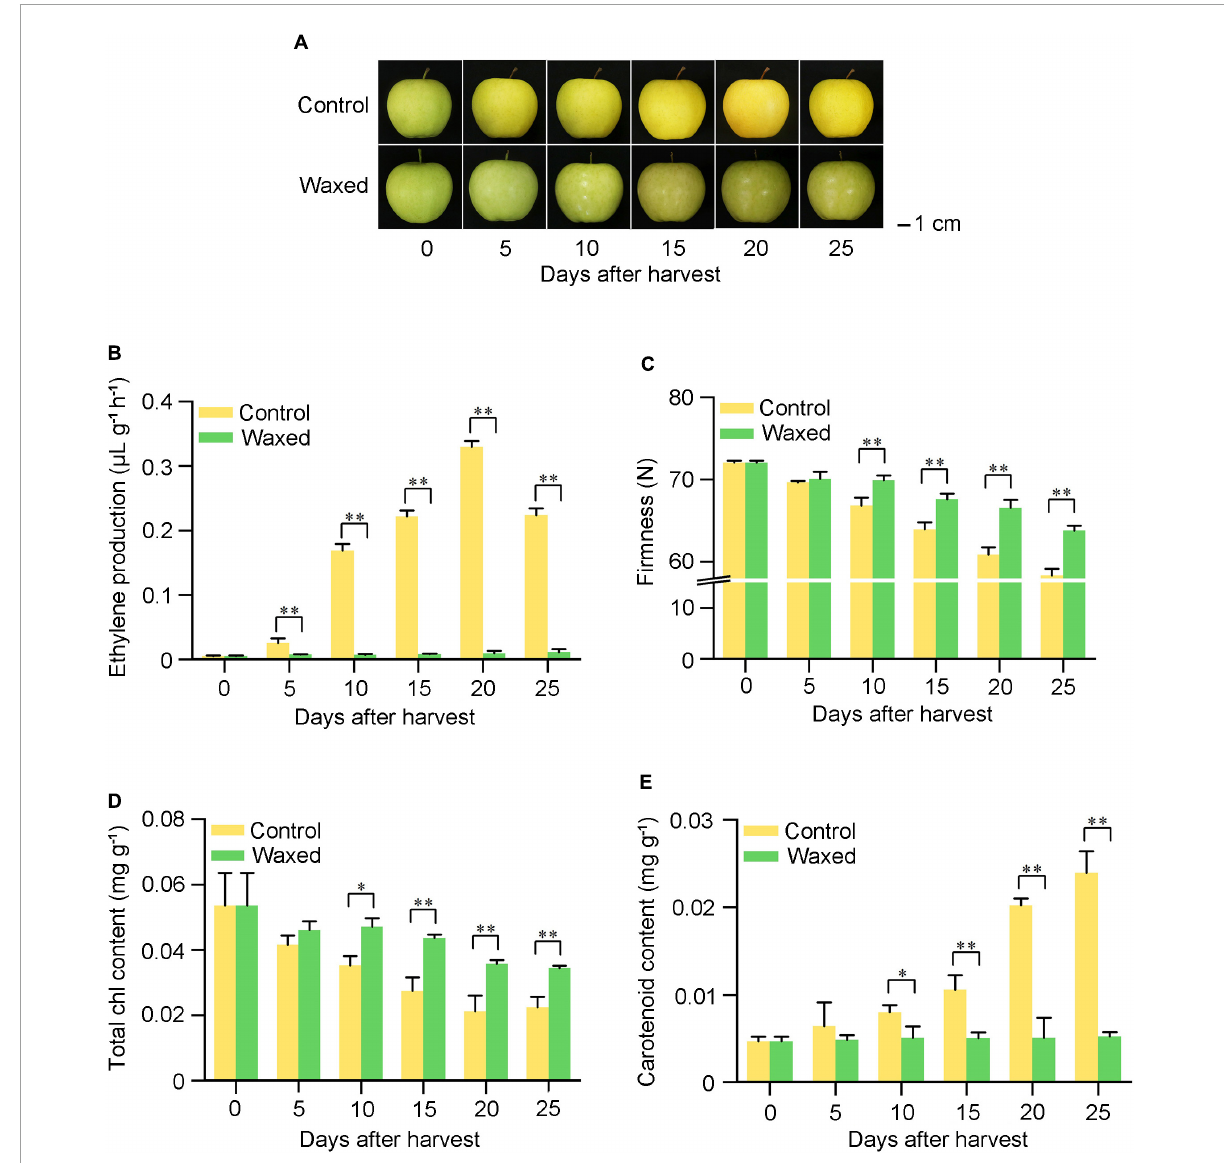
FIGURE1 Postharvest wax coating treatment inhibits apple fruit ripening. Apple fruit were collected on the commercial harvest day (145 DAFB) in 2020 and storage at room temperature for 25 days (A) . After treatment, ethylene production (B) , fruit firmness (C) , total Chl content (D) , and carotenoid content (E) were measured. Control, apple fruit not receiving treatment; Waxed, fruit treated with morpholine fatty acid salt fruit wax. Scale bar = 1 cm. The x-axis represents days of storage at room temperature after harvest. Five bioligical replicates were analyzed for ethylene production, fruit firmness, and three bioligical replicates for total Chl content and carotenoid content. Values represent mean ± SE. Statistical significance was determined using a Student’s t -test, and * p < 0.05, ∗∗ p <